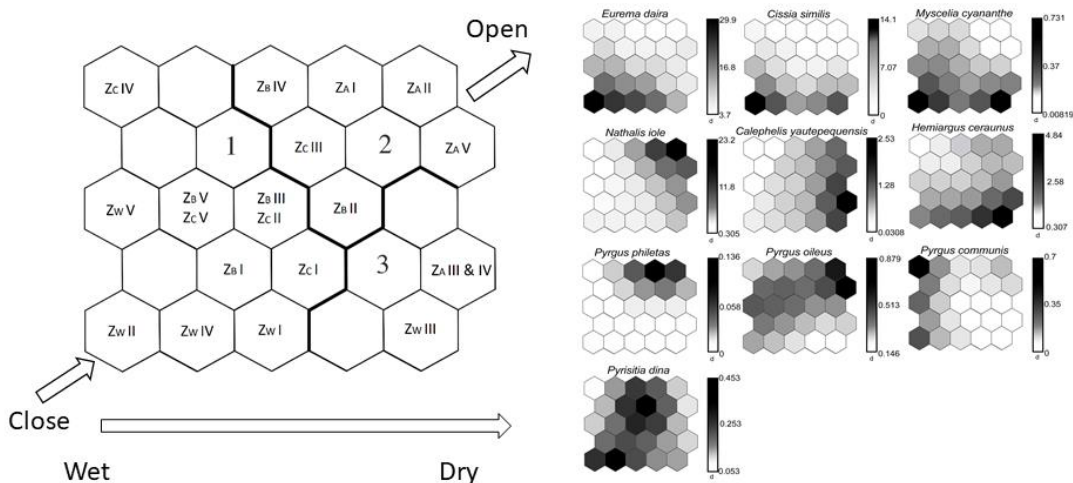
Figure 3. Probabilities of occurrence and distribution (SOM) of sampled Lepidoptera for dry season. Left side: Kohonen (SOM) map for the four studied sites (2 years of sampling; roman numerals are months, Zones A to W are noted Za to Zw). Horizontal gradient from left to right side denotes from humid to dry. Diagonal from left bottom corner to up right is from closed to open habitat. See Figure 2 for more information.